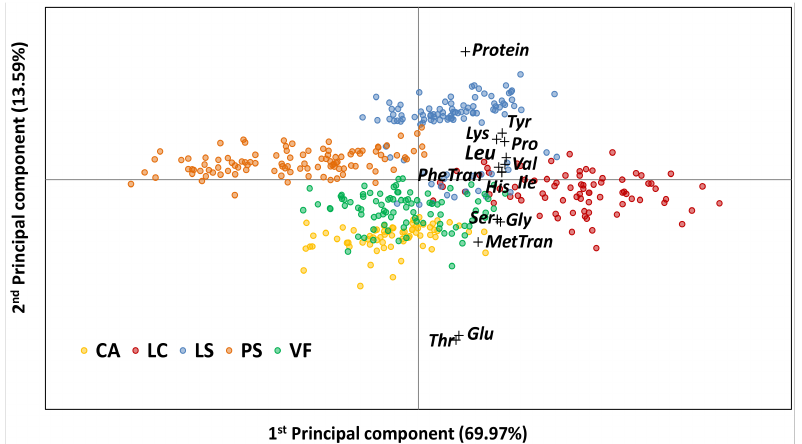
Figure 3. Principal component analysis biplot based on 17 traits related to protein quantity and quality in five grain legume species. Legend: in yellow, Cicer arietinum (CA), n = 86; in red, Lens culinaris (LC), n = 92; in blue, Lathyrus sativus and their crop wild relatives (LS), n = 109; in orange, Pisum sativum and their crop wild relatives (PS), n = 118; and in green, Vicia faba (VF), n = 92. The variance explained by each principal component is given in the axis heading.